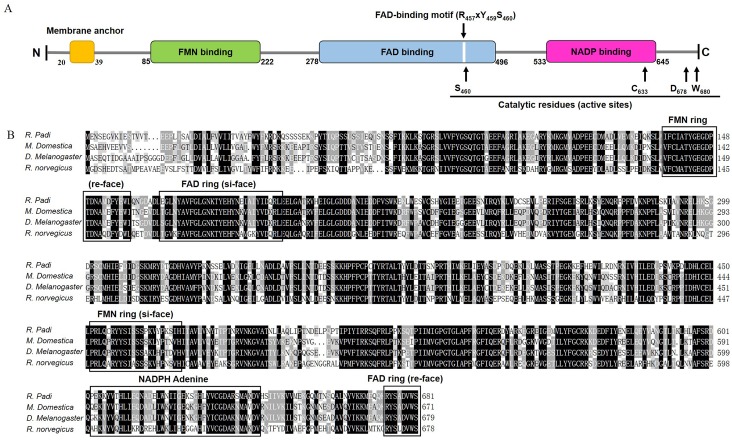
Sequence analysis of R. padi CPR.(A) Schematic drawing of RpCPR. Membrane anchor, conserved FMN-, FAD- and NADP-binding domains, FAD-binding motif (Arg457 x Tyr459 Ser456), and catalytic residues (Ser460, Cys633, Asp678 and Trp680) are shown. (B) Comparison of the deduced amino acid sequence of RpCPR with those of other CPRs deposited into GenBank. The species and accession numbers are as follows: Musca domestica (NP_001273818), Drosophila melanogaster (NP_477158) and Rattus norvegicus (NP_113764).